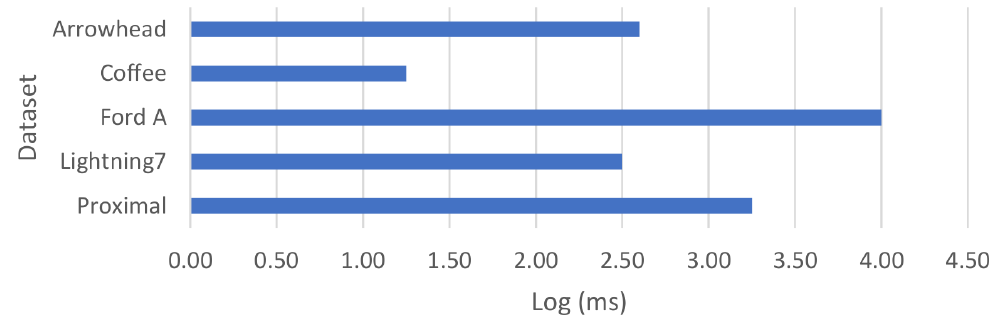
Figure 9. Processing time of the clustering algorithm for different data